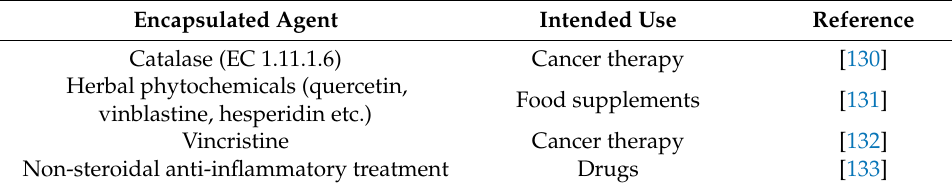
Table 5. Overview of the recent published uses of